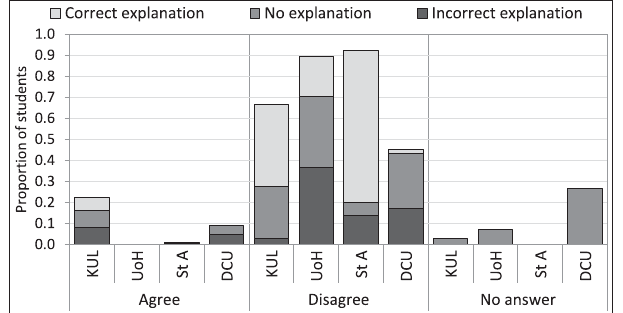
FIG. 8. Distribution of responses and corresponding